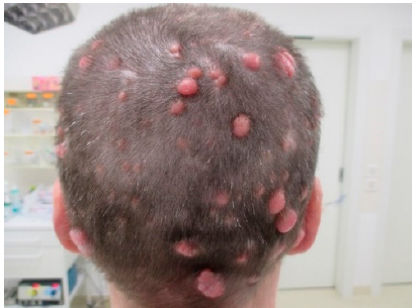
Figure 7. Scalp cylindromas and spiradenomas.